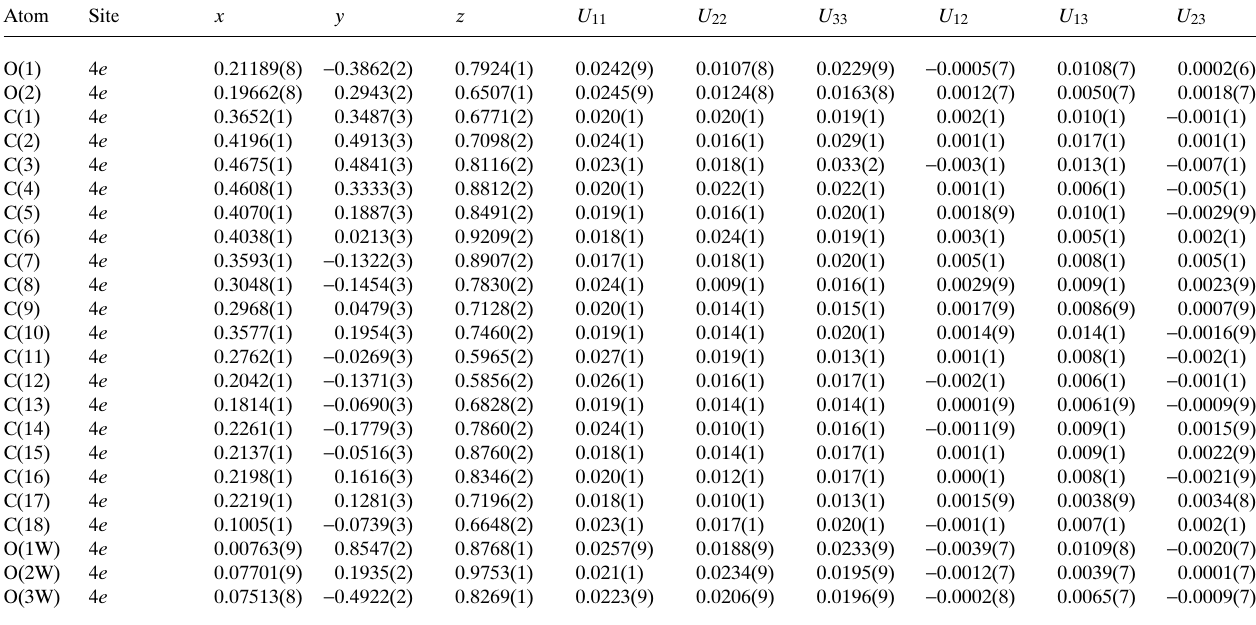
Table 3. Atomic coordinates and displacement parameters (in Å 2 )